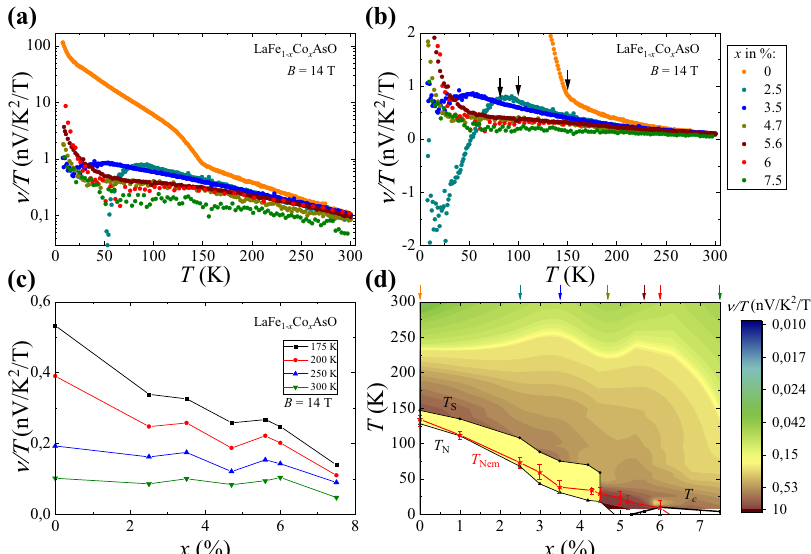
Fig. 3 Nernst effect measurements in LaFe 1 − x Co x AsO. Nernst coef fi cient divided by temperature ν / T of LaFe 1 − x Co x AsO as a function of T and x . All data measured along the ab -plane with a magnetic fi eld of B = 14 T applied parallel to the c -axis. a ν / T as a function of temperature (note the semi-logarithmic scale). b Zoom-in on the data shown in panel ( a ). Black arrows indicate structural phase transitions. c ν / T vs. Co doping level x at selected temperatures. d Colour-coded phase diagram of the Nernst coef fi cient divided by temperature ν / T as a function of Co doping level x and temperature T . Coloured arrows on the top mark show the nominal doping of the measured samples. T S , T N , T c , and T nem data taken from ref. 28